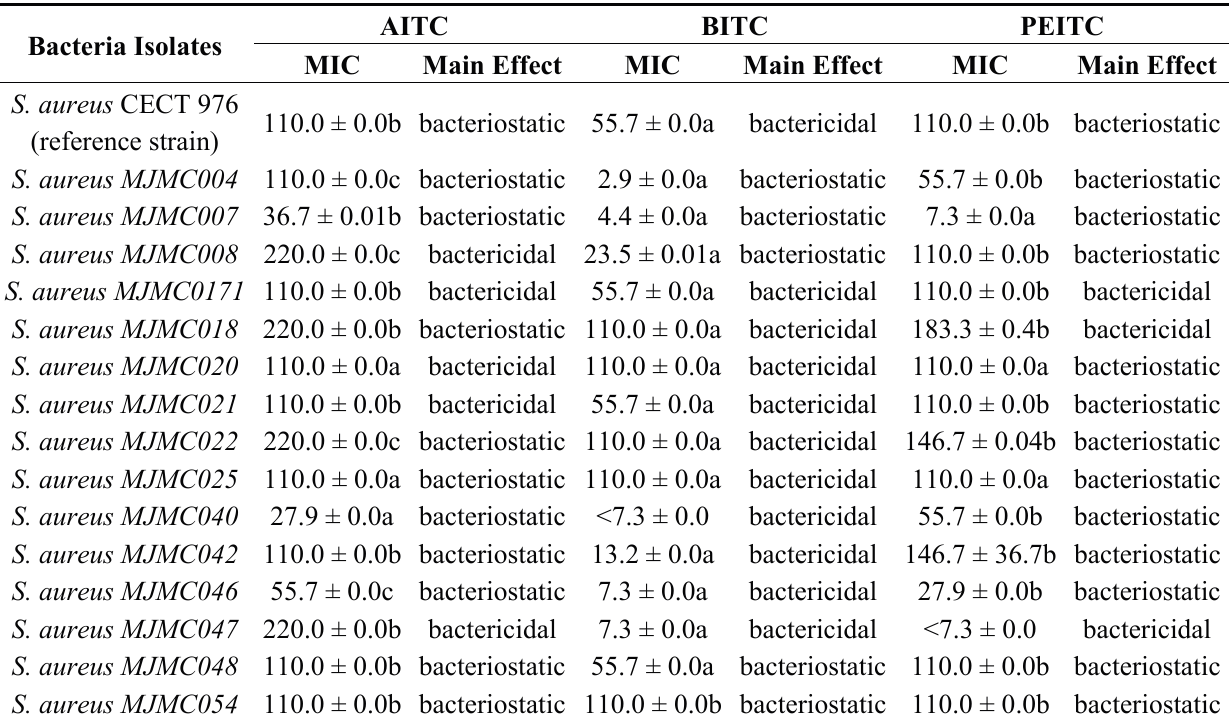
Table 2. Minimum Inhibitory concentration (MIC) (µg·mL − 1 ) and bacterial effect of ITCs against MRSA isolates.